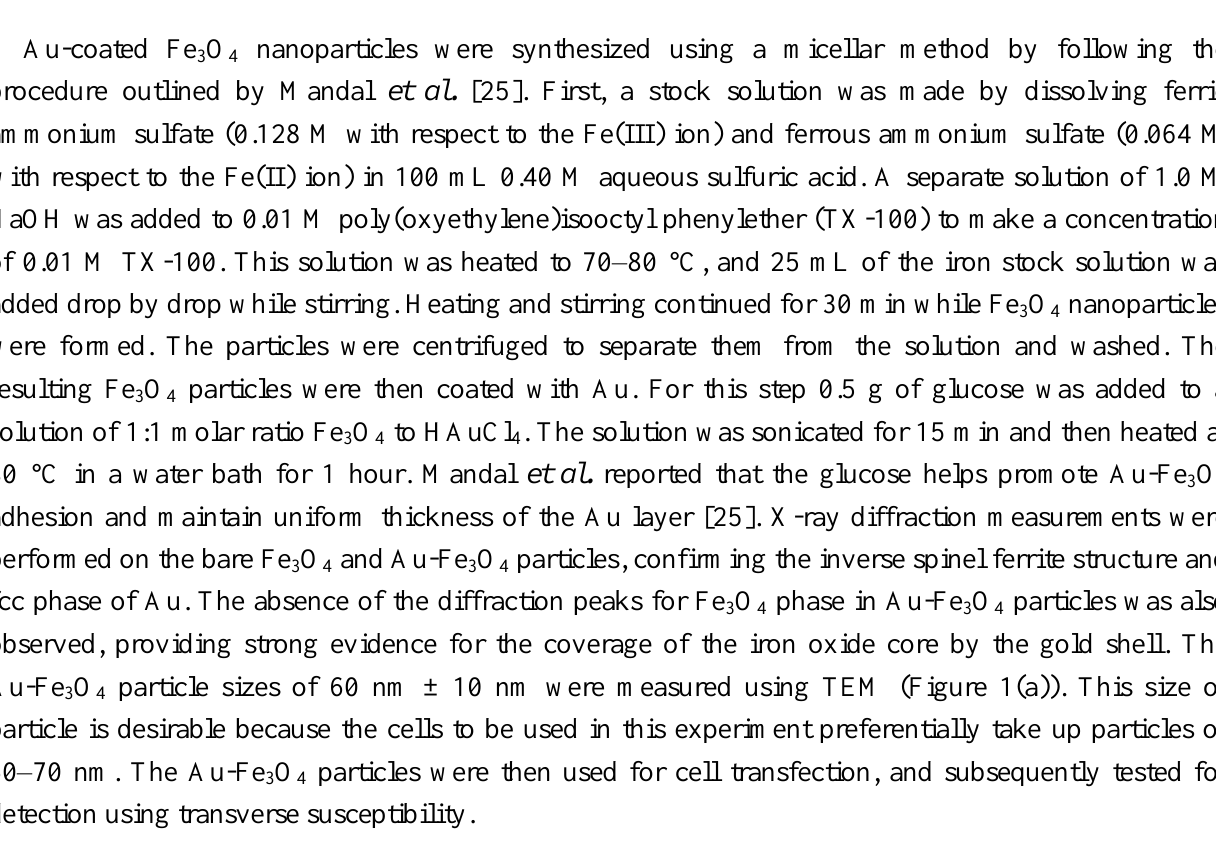
O nanoparticles; ( b ) Optical and ( c ) TEM images of 3 4